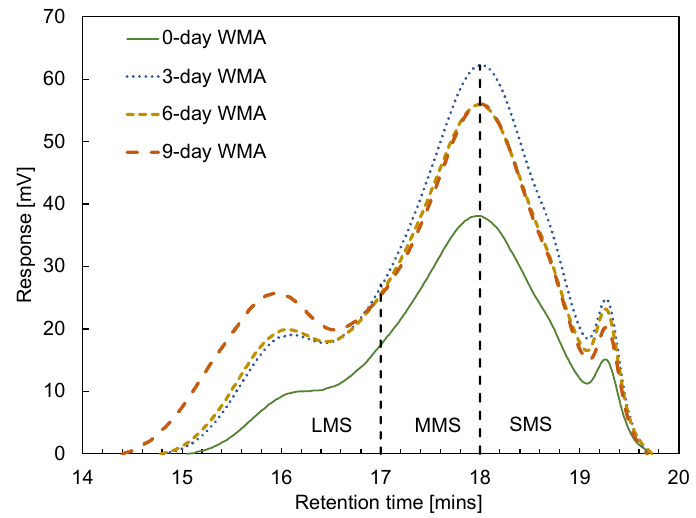
Figure 9. GPC curves for the binders of group 4.